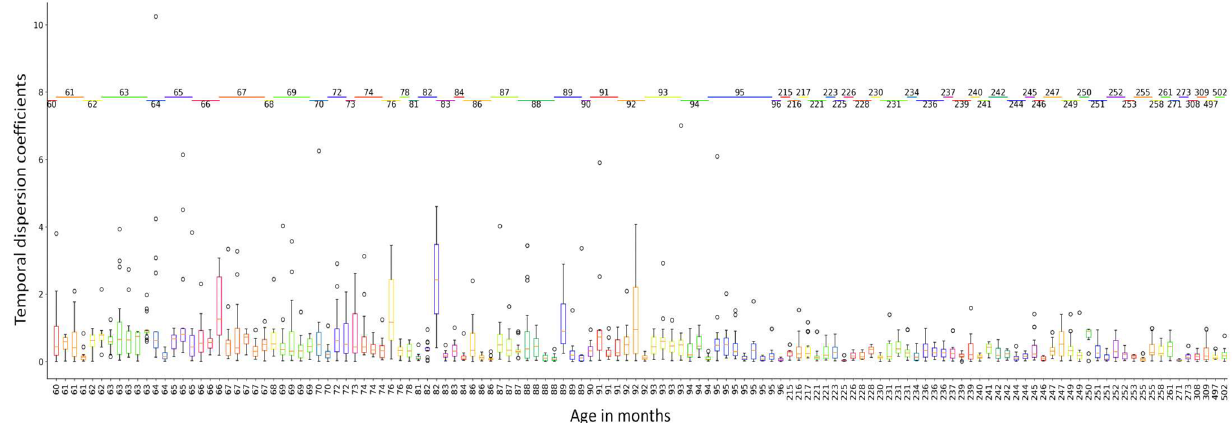
Figure 6. Box-and-whisker of the temporal estimation bias in children and adults with outsider productions represented by circles.